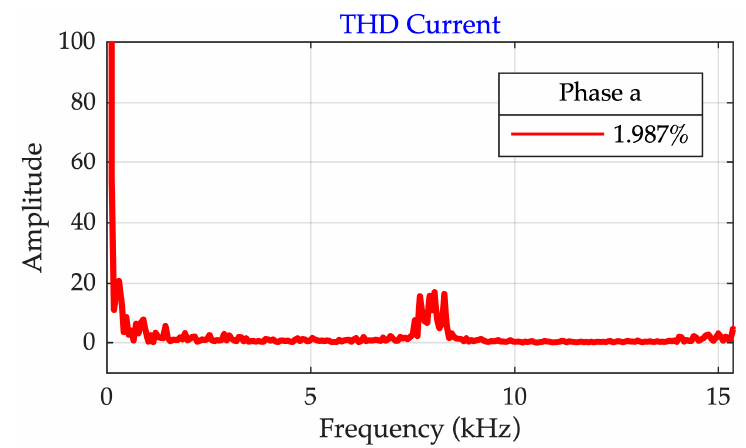
Figure 11. THD current injected into the distribution grid with phase shift angle in the DSPWM switching signals applied to the AFE converter.